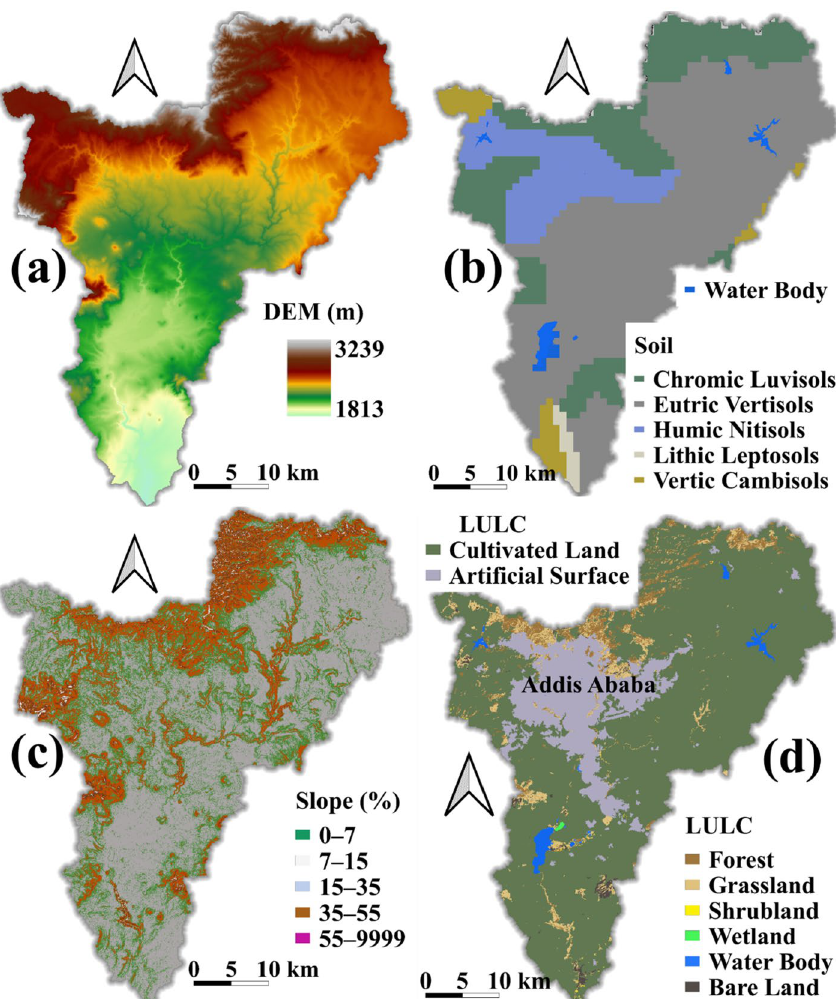
Figure 2. SWAT model inputs mapped using QGIS3.10.4 (https:// www. qgis. org/ en/ site/): ( a ) Digital Elevation Model (DEM 30 m, USGS; https:// earth explo rer. usgs. gov/), ( b ) Soil Classes 48 , ( c ) Slope classes, and ( d ) Land Use/Land cover (LULC) for the year 2000 47 .